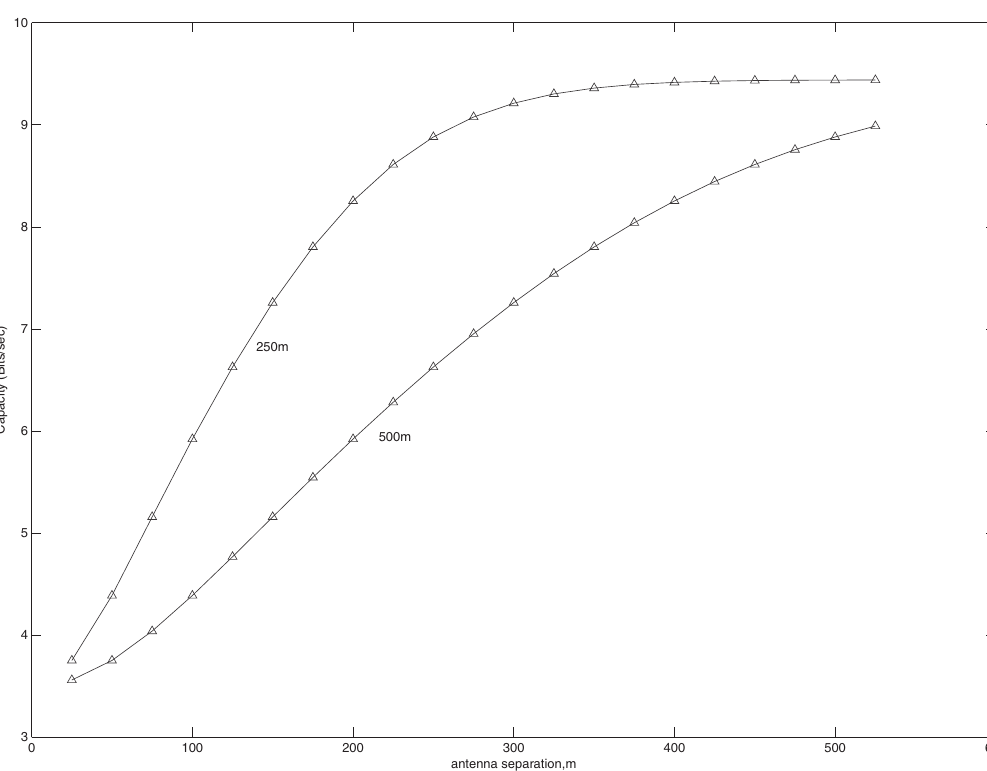
Fig. 5. Capacity achieved for correlation lengths of 250 and 500 m for a 4x4 MIMO